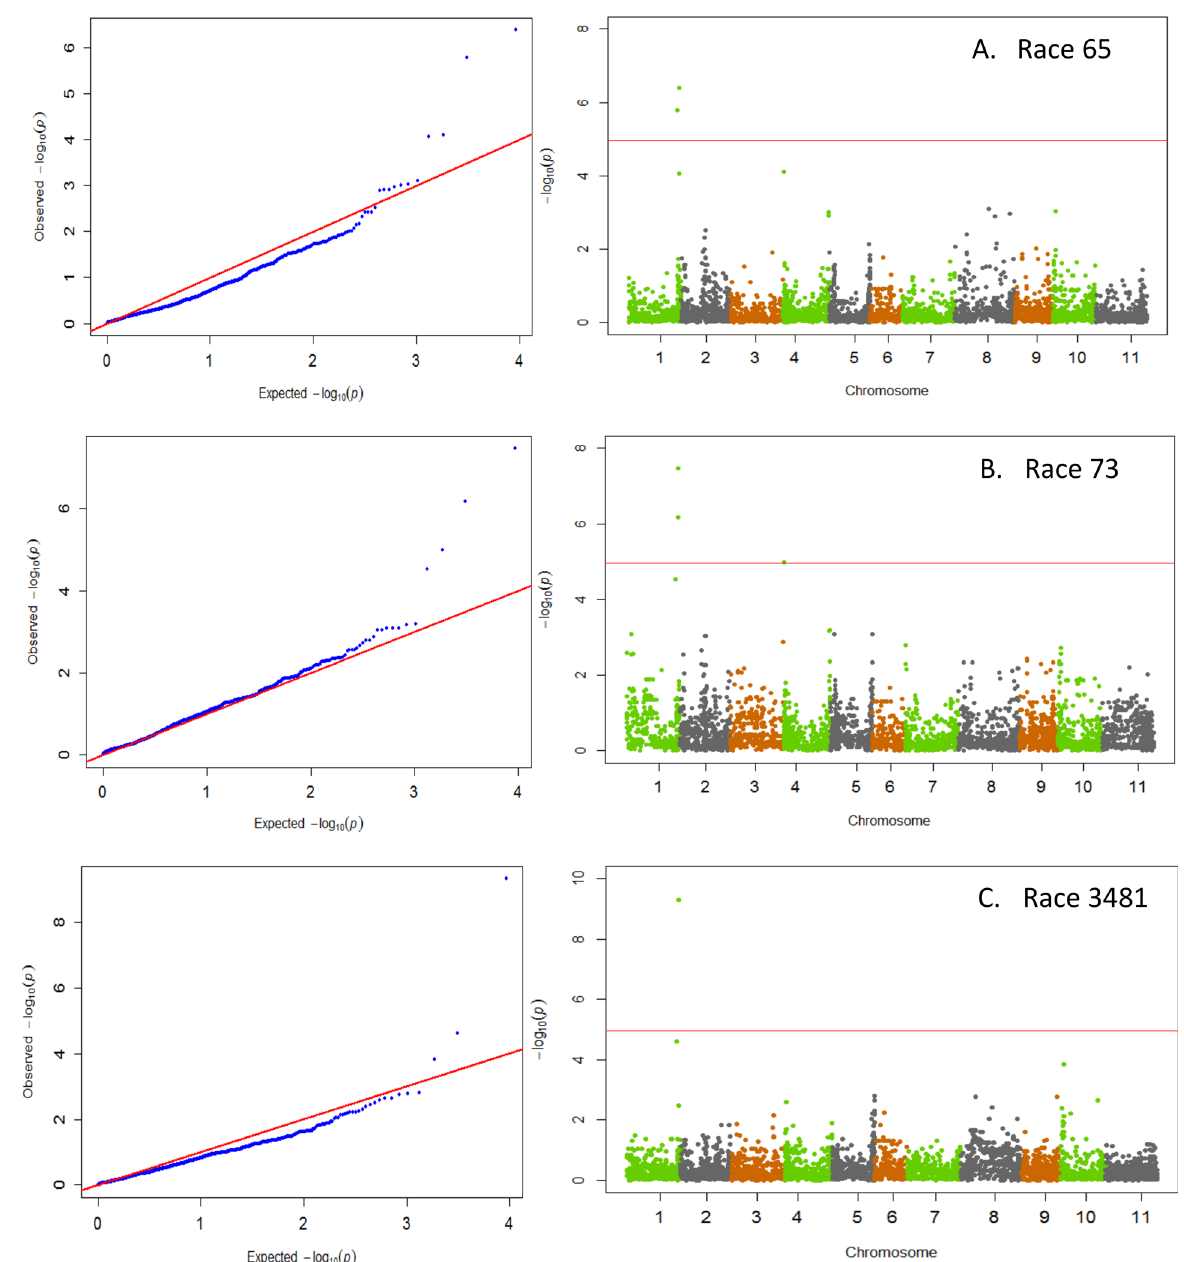
Fig 1. QQ and Manhattan Plots showing candidate SNPs and P-values from GWAS using MLM for anthracnose resistance. From top to bottom include results for anthracnose resistance to A) race 65, B) race 73, and C) race 3481 on Pv01. Red line on Manhattan Plots is the significance threshold of P = 1.03 x 10 − 5 after Bonferonni correction of α =